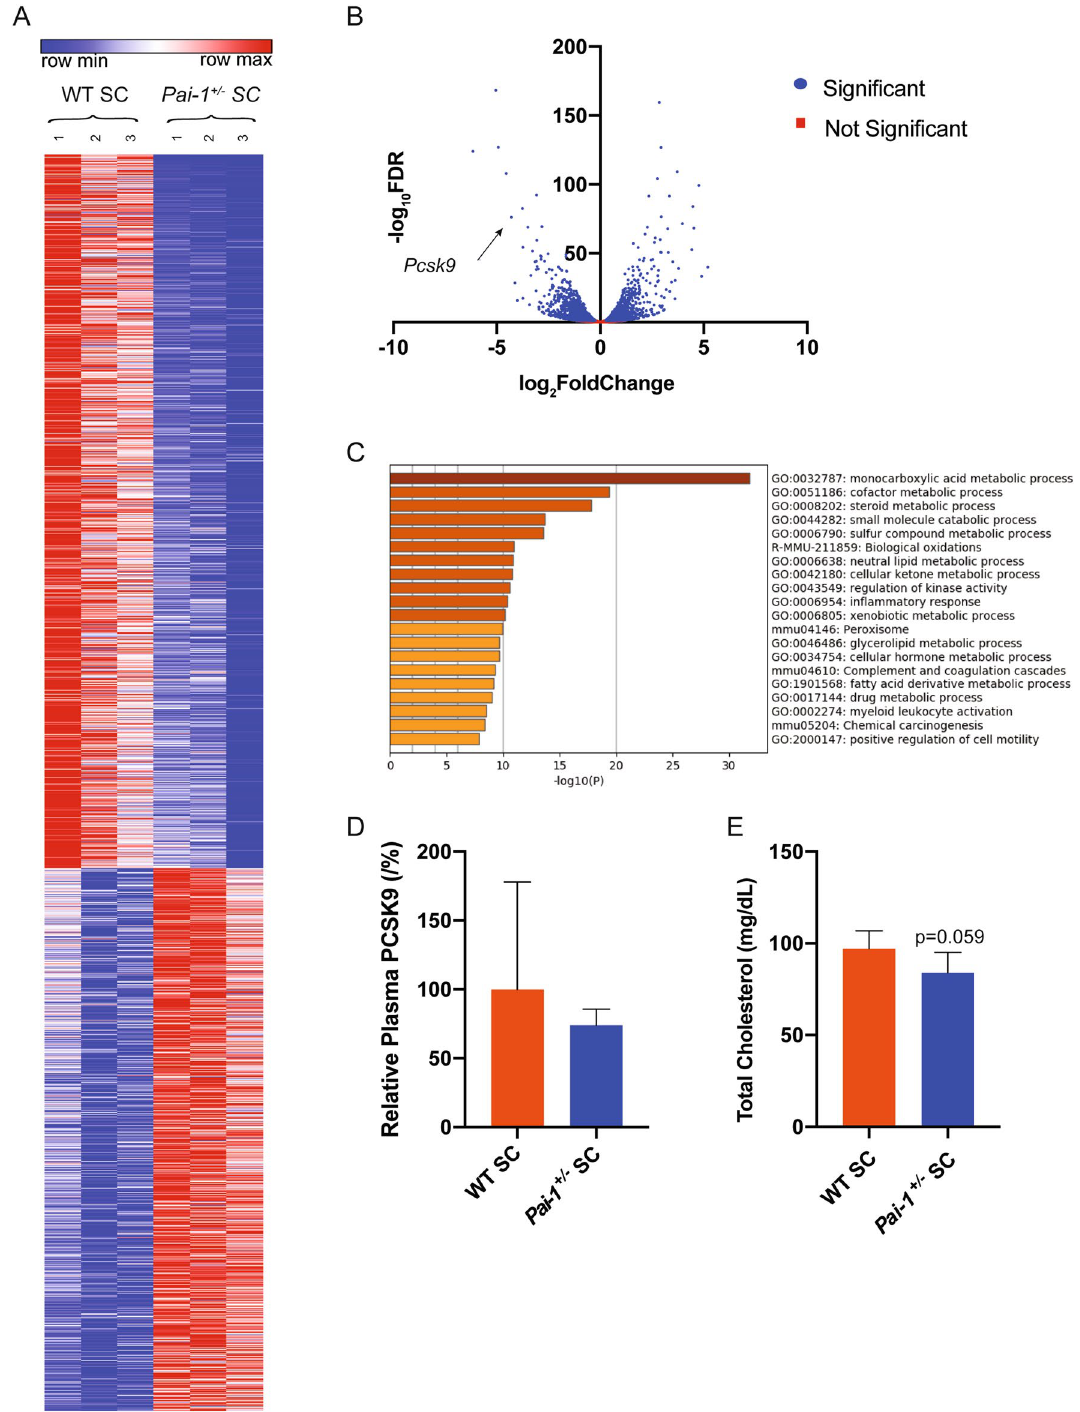
Figure 2. Lipid metabolism is differentially regulated in PAI-1 heterozygosity. RNA-SEQ was performed on hepatic mRNA from 20 week-old Pai-1 +/− and littermate WT control C57BL/6 J male mice fed SC (n = 3). ( A ) Hierarchical clustering of expression changes seen by RNA-seq. Heat map created using Morpheus (https ://softw are.broad insti tute.org/morph eus/). ( B ) Volcano plot representation of all gene expression changes. Blue points represent statistically significant changes and red points represent non-significant changes. ( C ) Gene ontology analysis of statistical differentially expressed genes. Data generated using Metascape (https ://metas cape.org/ gp/index .html#/main/step1 ). ( D ) Murine PCSK9 plasma levels. ( E ) Total cholesterol plasma levels. Values are express as mean ± SEM (n =